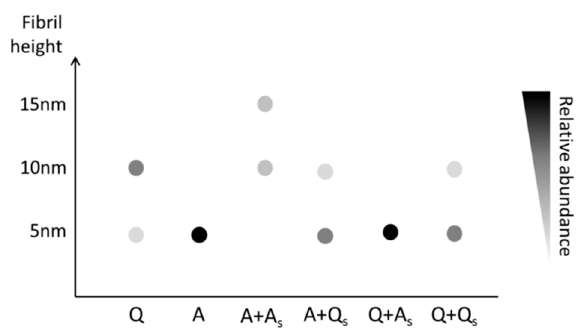
Figure 8. Schematic of the height measurements by AFM performed on fibrils prepared under different conditions. Quiescent (Q) incubation generates two species of fibrils with heights 5 and 10 nm, whereas agitated (A) growth only forms 5 nm fibrils. Upon seeding with seeds formed from sonicated A fibrils (A s ) or quiescent fibrils (Q s ), fibril dimensions are largely determined by the seed species, except for A + A s (see text for explanation of this phenomenon).